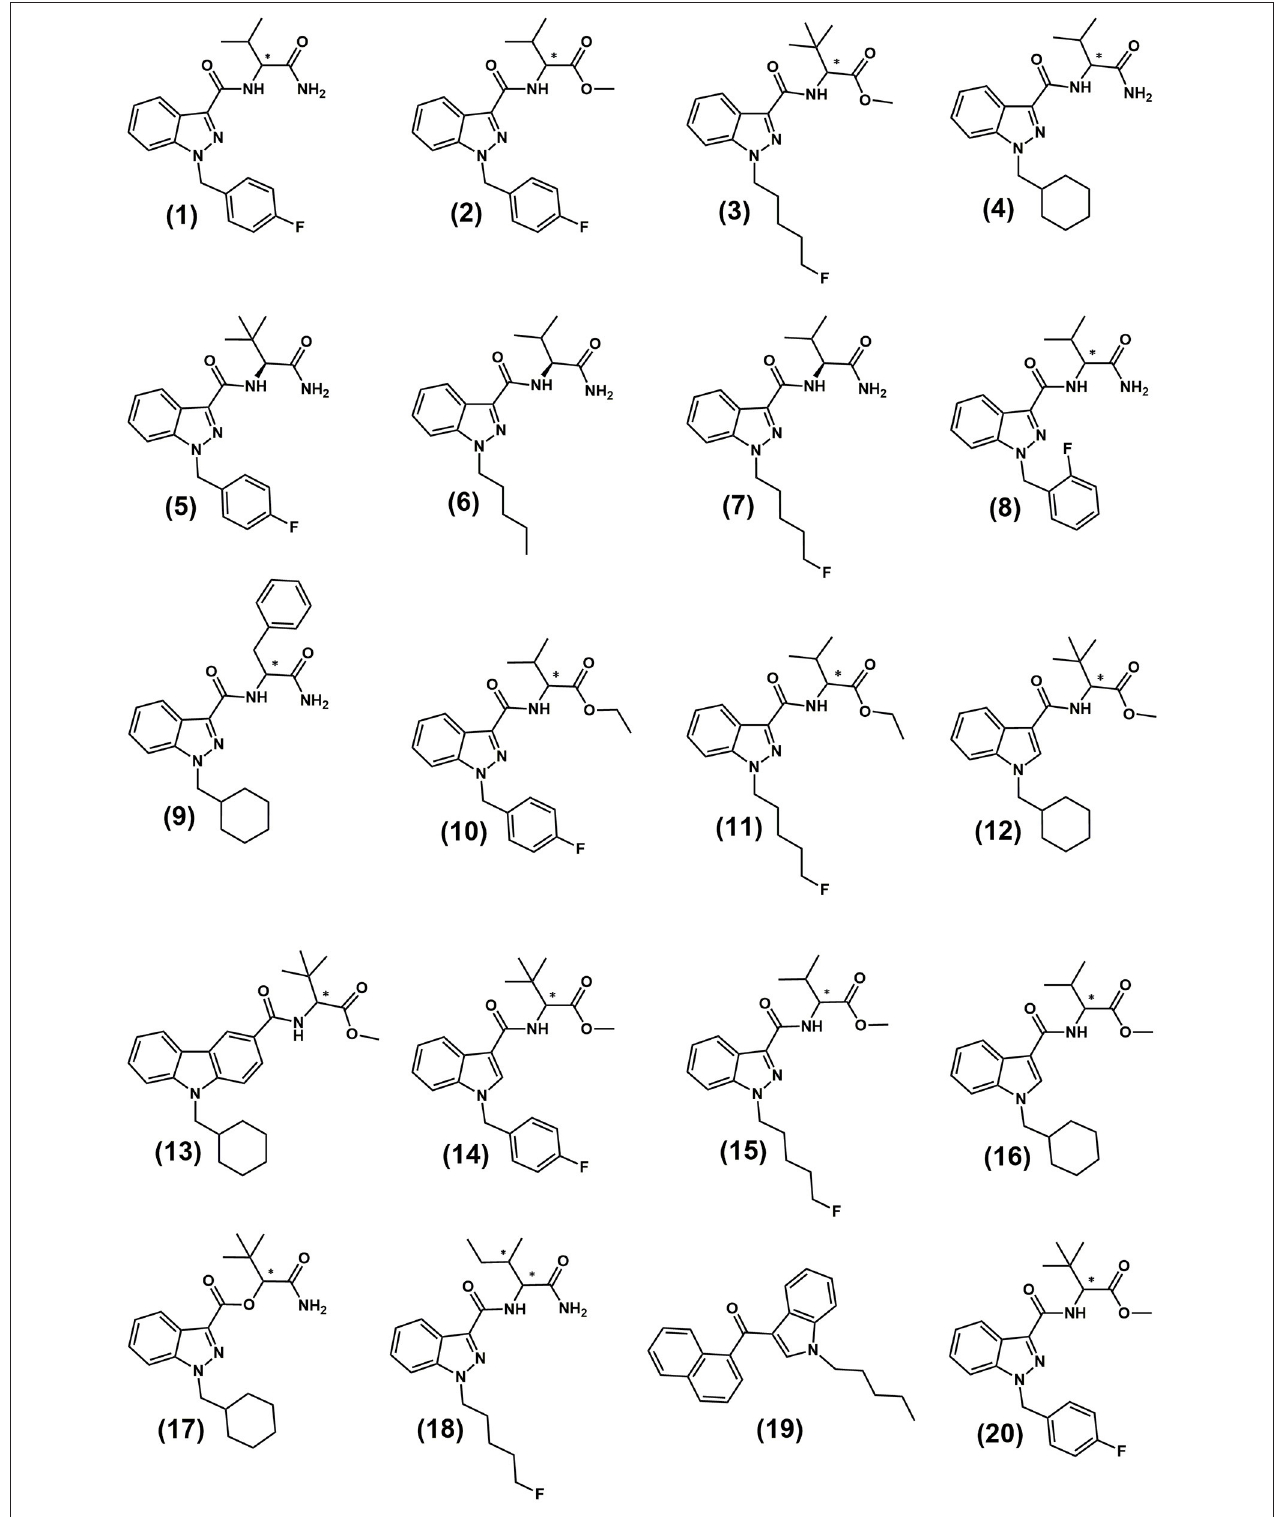
FIGURE 1 | Structures of the indazole-3-carboxamide synthetic cannabinoids utilized in this study and in previous studies. (1) AB-FUBINACA; (2) AMB-FUBINACA; (3) 5F-MDMB-PINACA (5F-ADB); (4) AB-CHMINACA; (5) ( S )-ADB-FUBINACA; (6) ( S )-AB-PINACA; (7) ( S )-5F-AB-PINACA; (8) AB-FUBINACA 2-fluorobenzyl isomer; (9) APP-CHMINACA; (10) EMB-FUBINACA; (11) 5F-EMB-PINACA (12) MDMB-CHMICA; (13) MDMB-CHMCZCA (14) MDMB-FUBICA; (15) 5F-AMB; (16) AMB-CHMICA (MMB-CHMICA); (17) ADB-CHMINACA (MAB-CHMICA); (18) ( 1S,2S )-5F-ADB-PINACA isomer 2. (19) JWH-018; (20) MDMB-FUBINACA. *Indicates the position of the chiral